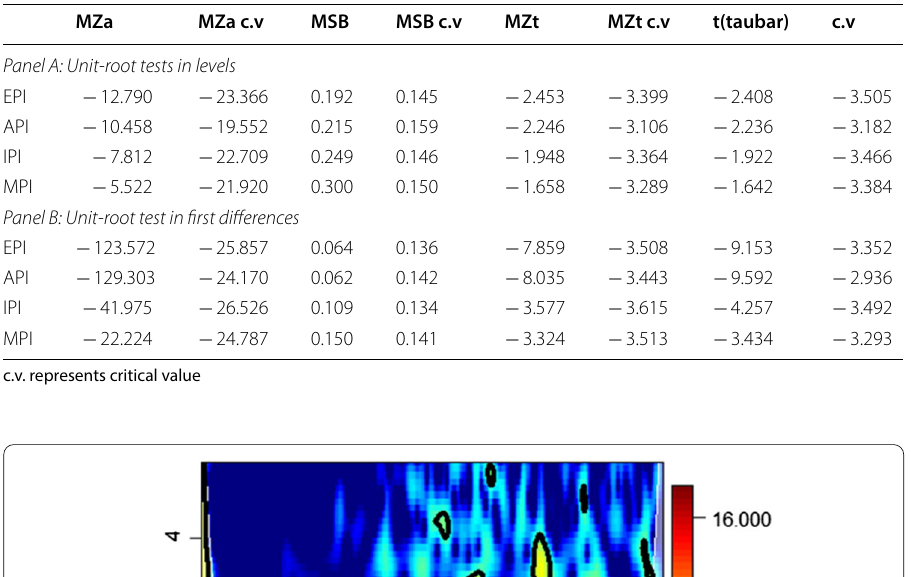
Table 3 Results of the test for unit roots in the presence of a possible break in trend and non-stationary volatility